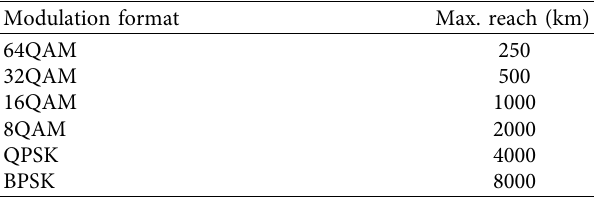
Table 1: Maximum reach for each modulation format [50].